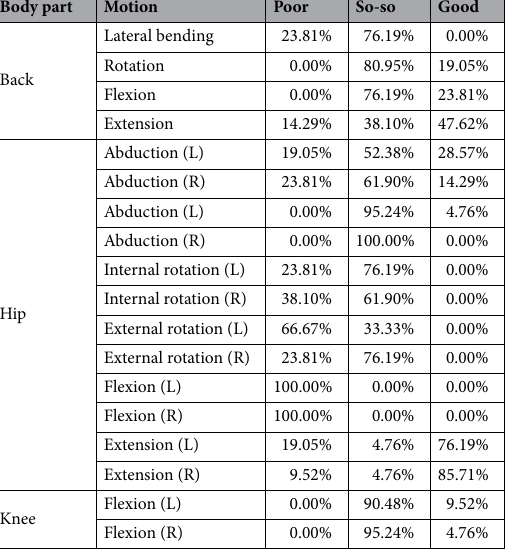
Table 4. Percentage of LF collectors with poor, so-so and good posture for different types of back, hip and knee joint motion (n = 8).